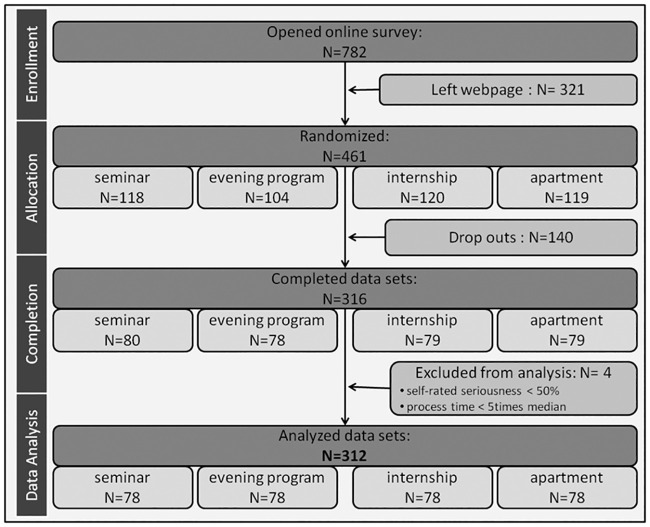
Study flow chart: Reduction process of N = 782 participants that opened the online survey to N = 312 that completed the study and were analyzed finally (with N = 78 for each vignette).